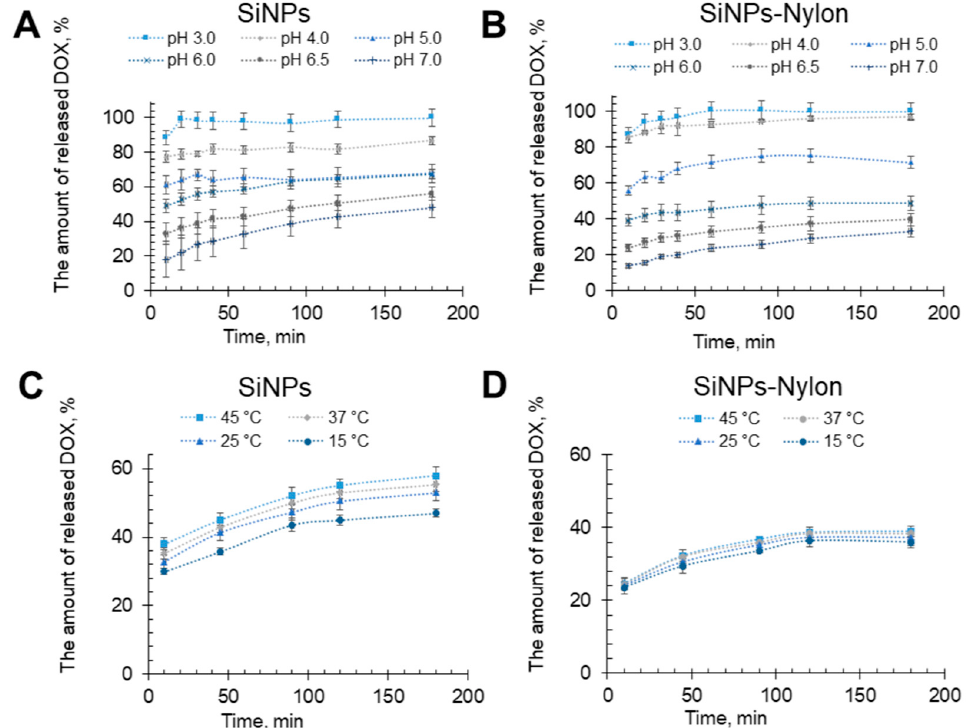
Figure 5. DOX release from SiNPs-DOX ( A , C ) and SiNPs–Nylon-DOX ( B , D ) at pH 3.0–7.0 at 25 °C (up) and pH 6.5 at 15–45 °C (bottom). The SiNPs-Nylon-DOX with a capacity of 493 μ g/mg (size 137 ± 2 nm by DLS) and SiNPs-DOX 258 μ g/mg (size 147 ± 5 nm by DLS) were used for DOX release studies. All values are given as the mean ± standard deviation (SD) values. All measurements were repeated not less than three times.